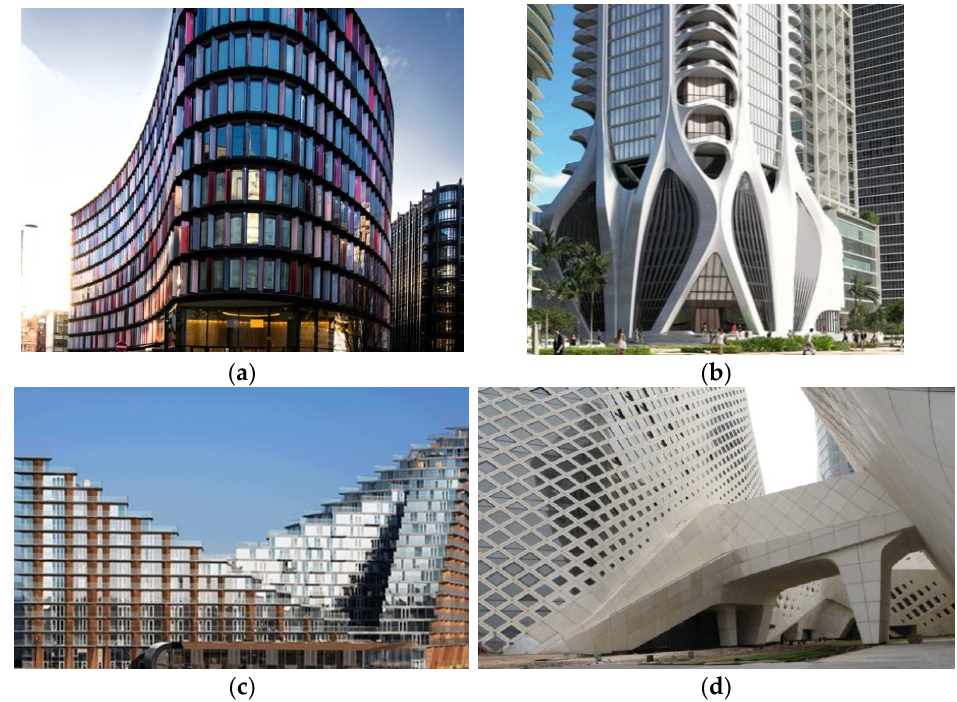
Figure 29. ( a ) Two New Ludgate, London, UK [124]; ( b ) 1000 Museum, Miami, USA [124]; ( c ) AARhus, Aarhus, Denmark [124]; ( d ) Nanjing Youth Olympic Conference Center, Nankin, China [124].